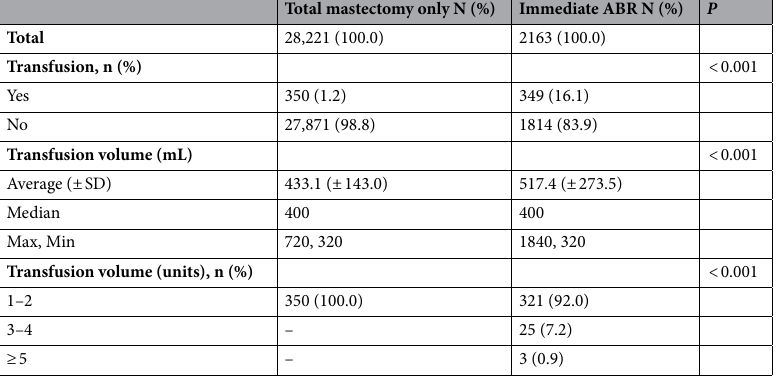
Table 2. Transfusion rates and volumes for the entire study population. ABR autologous breast reconstruction, SD standard deviation, Max maximum, Min